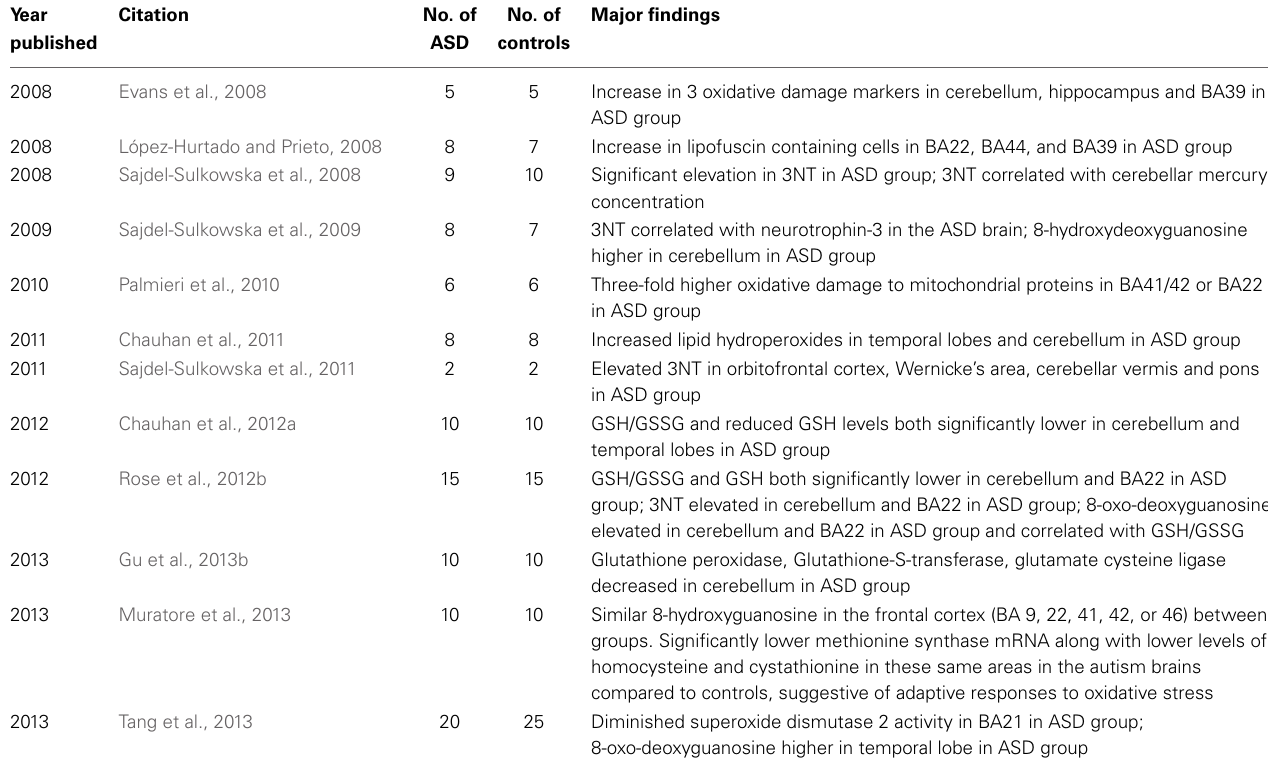
Table 1 | Studies of oxidative stress in the ASD